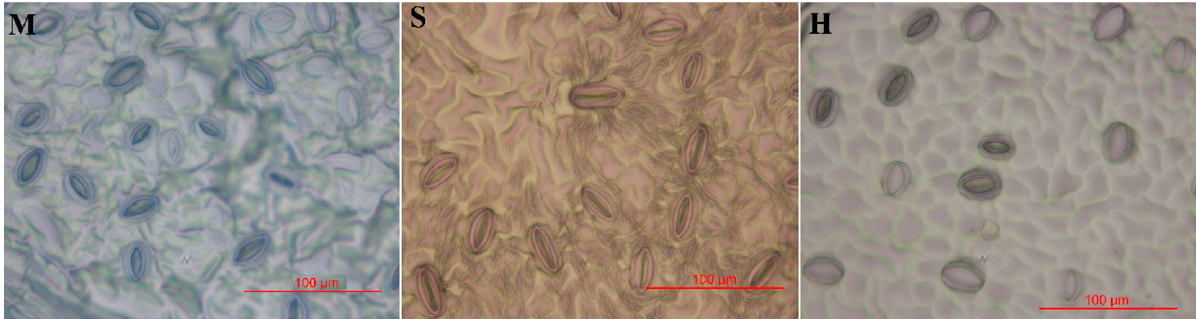
Table 1. Comparison of leaf stomatal density and stomatal closure ratio of different peach rootstocks under waterlogging stress.